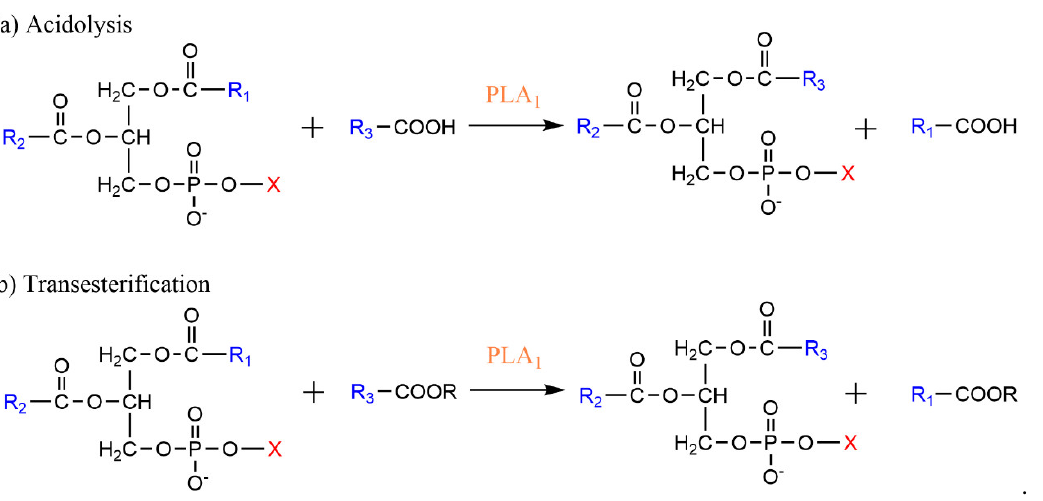
Figure 7. PLA 1 −catalyzed incorporation of different fatty acids into PLs via the acidolysis ( a ) or transesterification ( b ) reaction.